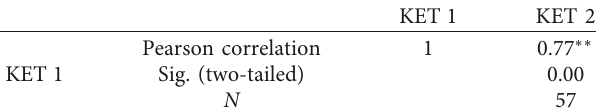
Table 1: Reliability of